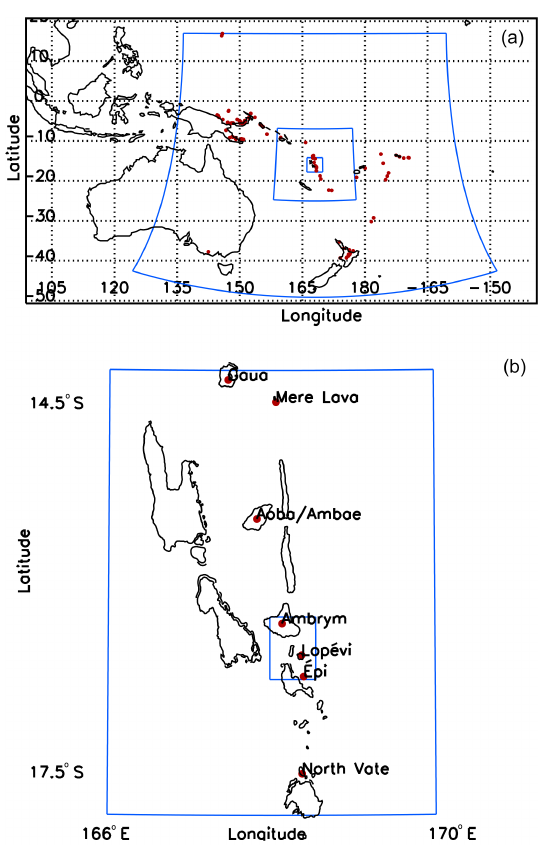
Figure 2. (a) Position of the nested model grids (blue lines) and of the volcanoes (red filled circles) taken into account in the sim- ulations. For clarity, only the three largest model grids are shown. (b) Zoom on the two smallest model grids (blue lines) and on the volcanoes (red filled circles) taken into account in the simulations. Resolution of each grid is given in Sect.